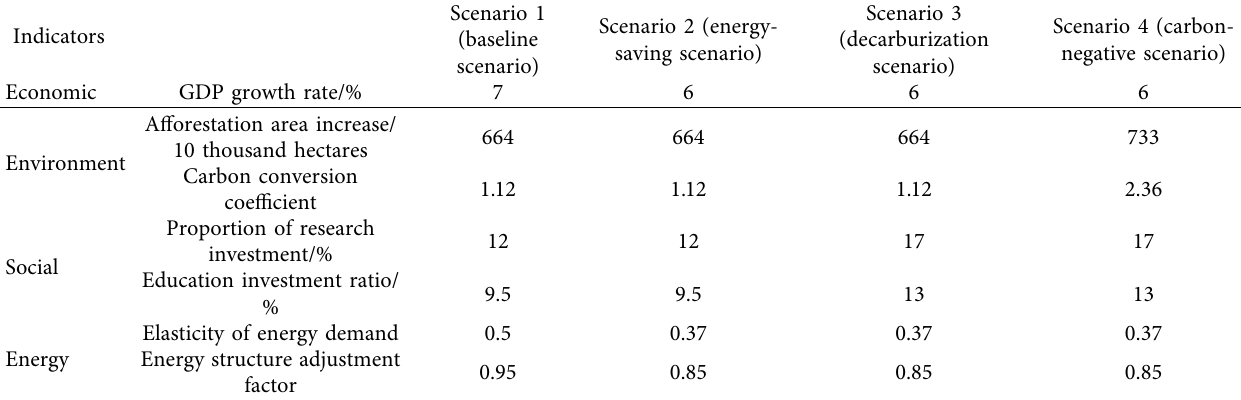
Table 4: Scenario simulation of carbon emission system indicators for public